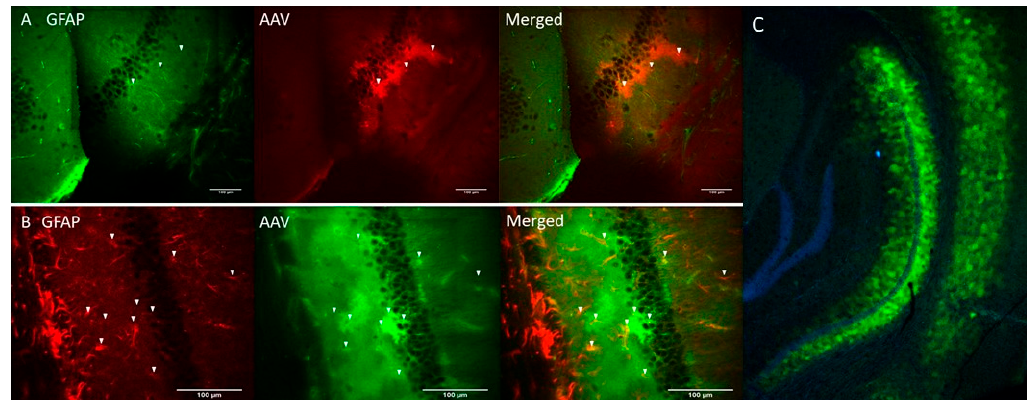
Figure 1. Astrocyte-specific expression of ChR2(H134R)-mCherry and Opto-a1AR-EYFP constructs. ( A ) Confocal images